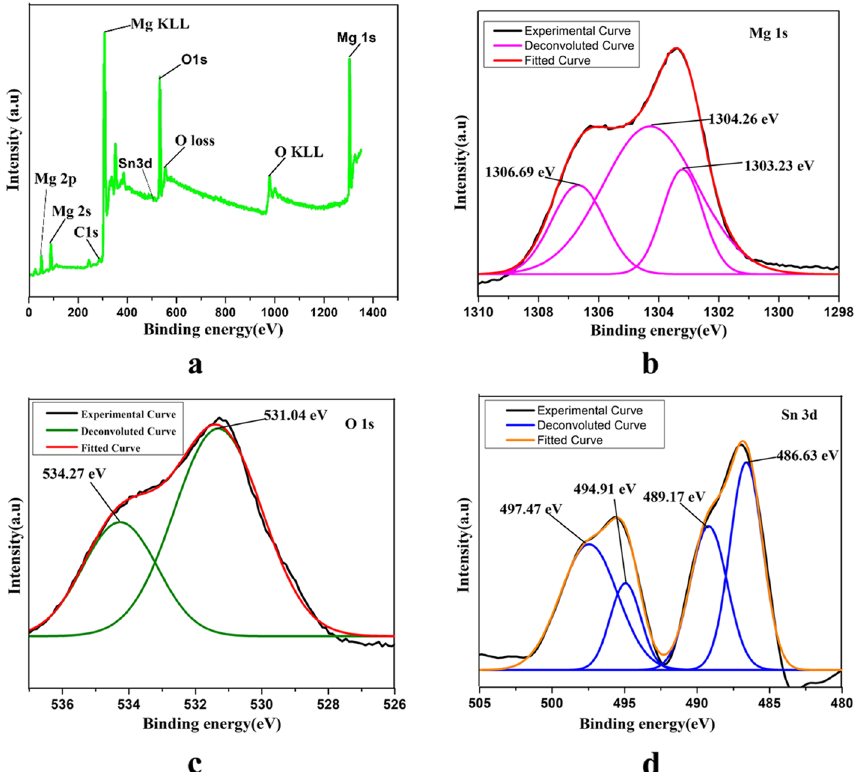
Fig. 6 a XPS spectrum of MgO-SnO 2 nanocomposite and XPS spectra of b Mg 1s core level, c O 1s core level, and d Sn 3d core level for MgO-SnO 2